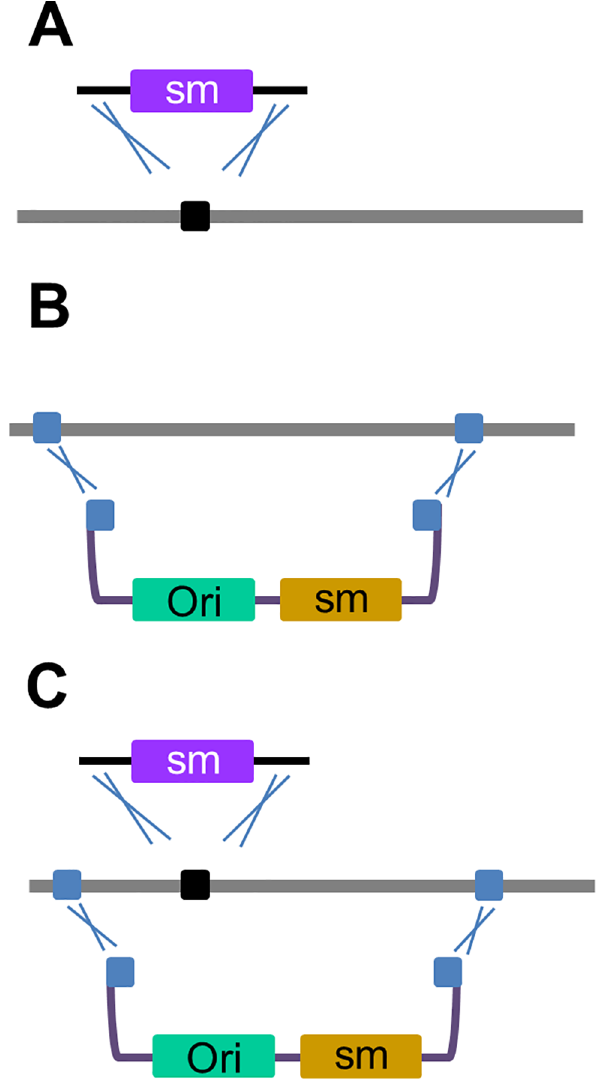
Fig 1. Different types of recombineering processes. (A) Insertional recombination. A selection marker (sm) containing homology to a target site is inserted during the process of DNA replication (dashed line). Gap repair cloning. A gapped plasmid with terminal homology regions to a target site is used to subclone a sequence of interest. (C) Subcloning plus insertion (SPI). Insertion of a cassette occurs simultaneously during subcloning and generates a targeted subcloned plasmid. The template DNA remains unmodified.